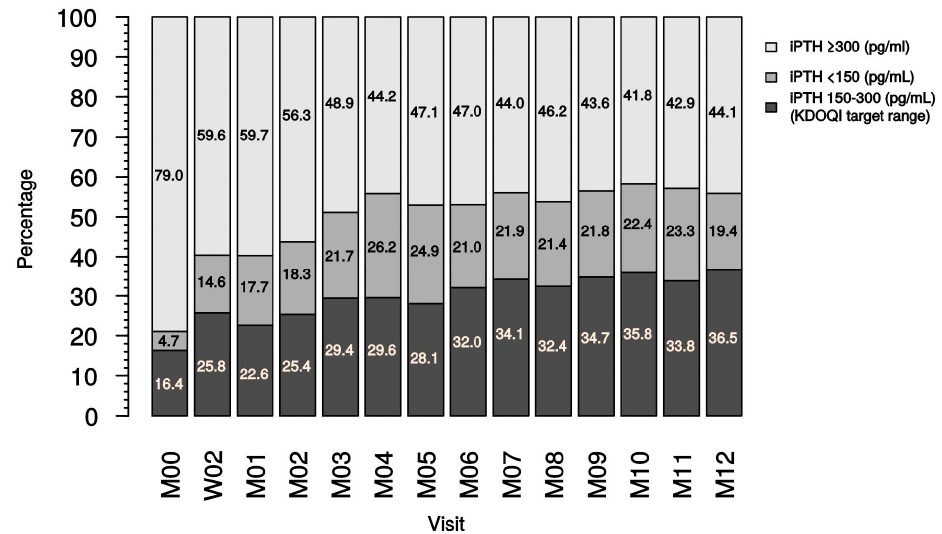
Figure 5. Distribution of iPTH ranges during the duration of the study (dialysis patient iPTH data). iPTH, intact parathyroid hormone; KDOQI, Kidney Disease Outcome Quality Initiatives; M, month; W, week.